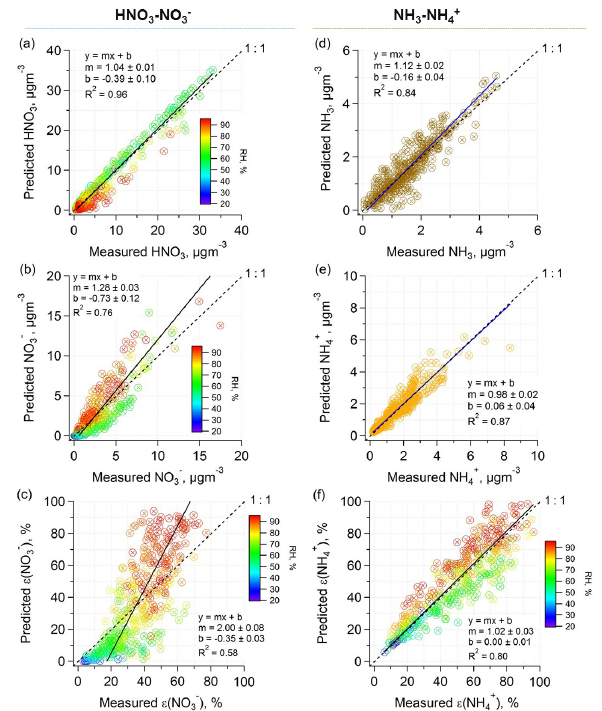
Figure 2. Comparisons of predicted and measured HNO 3 , NO − ) (a, b, c) and NH 3 , NH + and ε (NO − 3 data from the complete CalNex study. Particle-phase data are all AMS PM 1 . Orthogonal distance regression (ODR) fits are shown and uncertainties in the fits are 1 standard deviation.